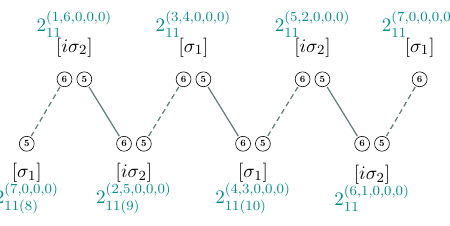
Figure 19 . T -duality chain of the E (10;3) -branes.